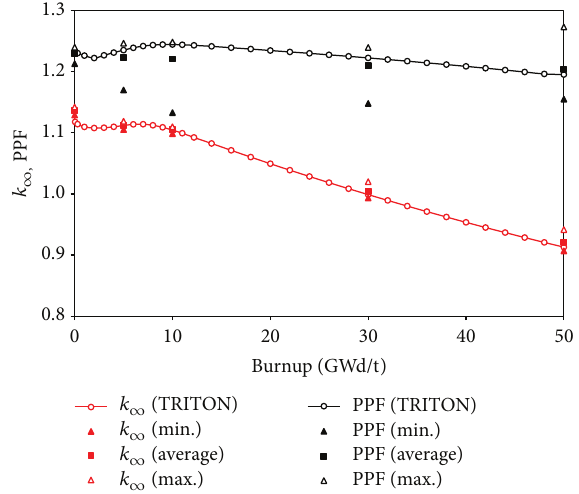
Figure 1: Comparison of the SCALE code and benchmark